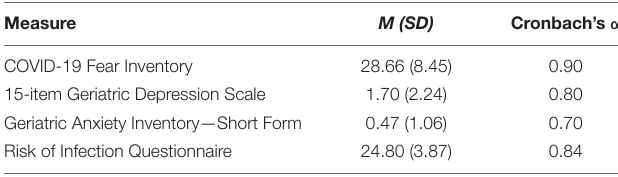
TABLE 2 | Descriptive statistics of key study